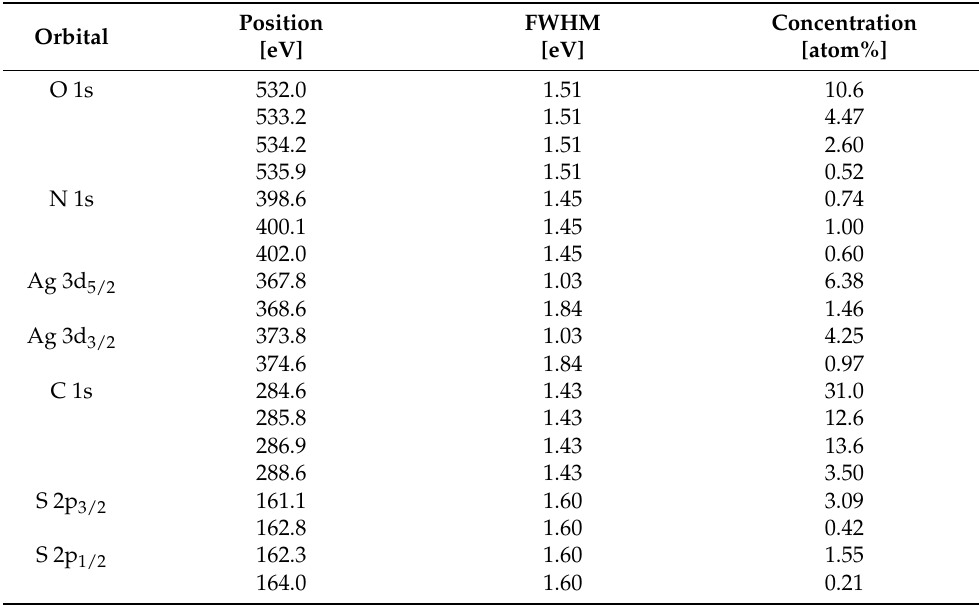
Table 1. Binding energy values and full width at half maximum (FWHM) of peaks with atomic concentrations, obtained from XPS analysis. Orbital